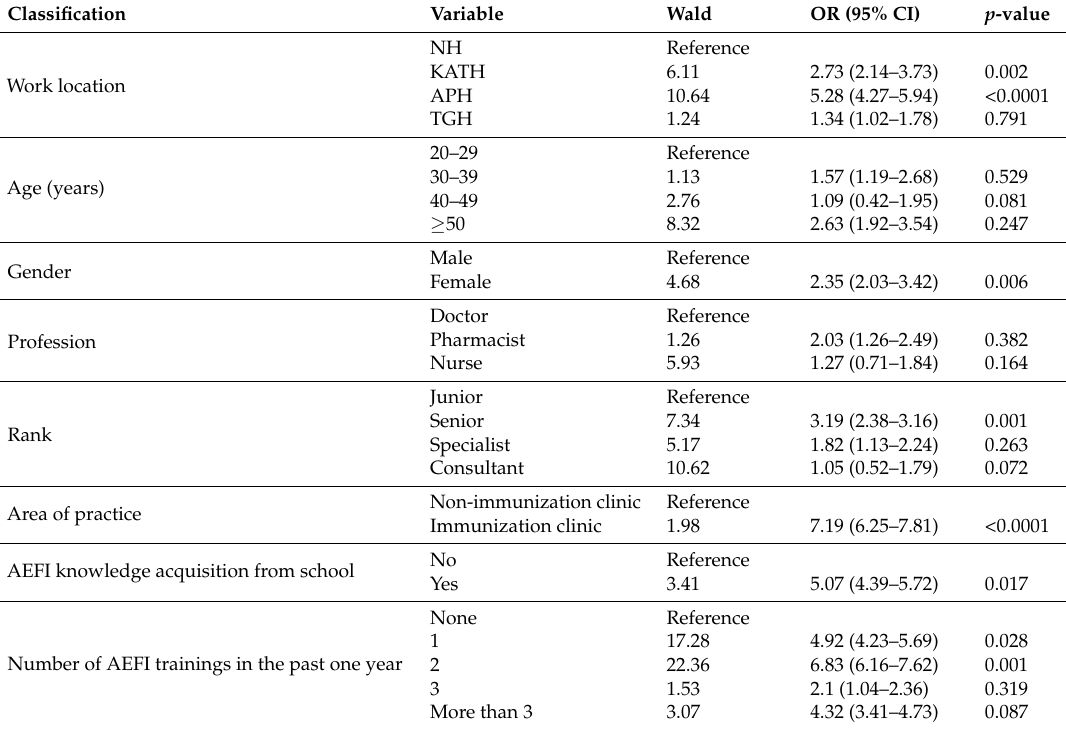
Table 6. Summary of binary logistic regression of good perception versus participant